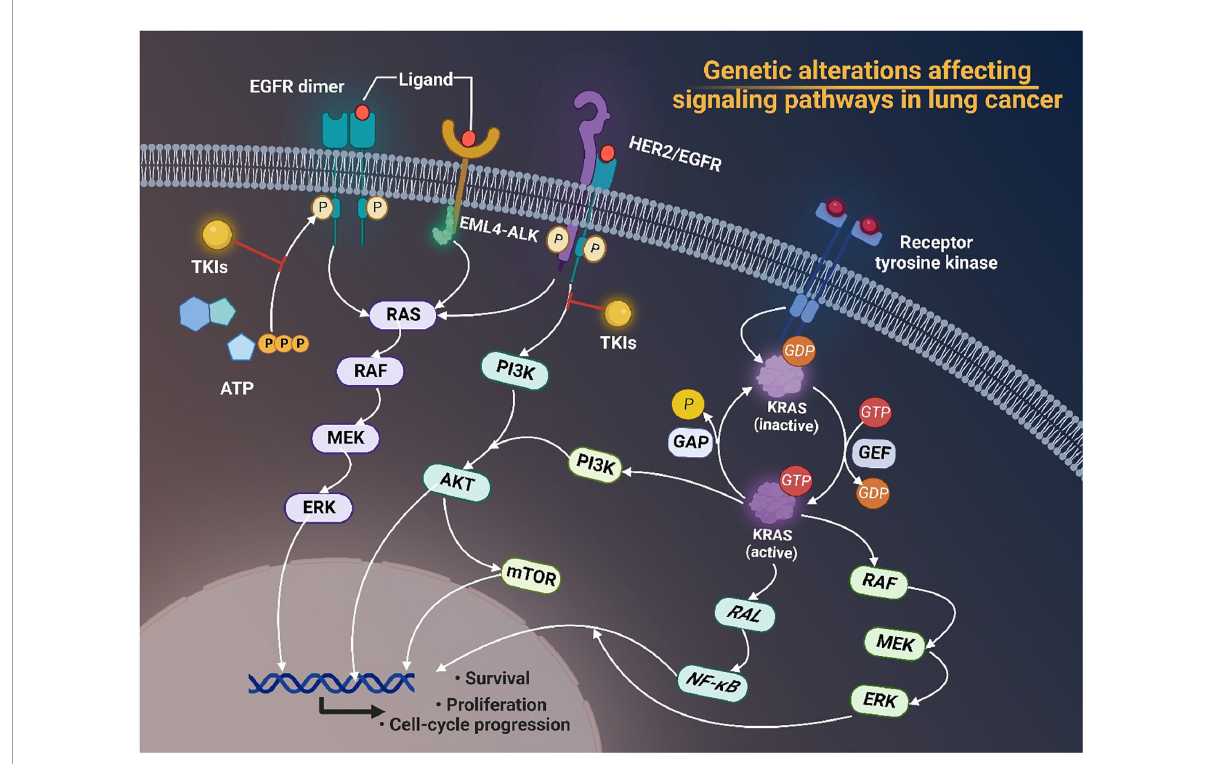
FIGURE1 Genetic alterations of EGFR, ALK, and HER2 affecting signaling pathways in lung cancer. Tyrosine kinase inhibitors (TKIs) target receptor tyrosine kinases and prevent phosphorylation of the TK domain receptor of EGFR, thus inhibiting the activation of downstream signaling pathways such as the RAS/RAF/MEK/ERK pathway and the phosphatidylinositol 3-kinase (PI3K)-AKT pathway, thereby interfering with cell proliferation, differentiation, migration and survival. Activated KRAS proteins principally activate the downstream PI3K-AKT-mTOR signaling pathway that regulates cell proliferation and the RAS-RAF-MEK-ERK signaling pathway that regulates cell growth. Tumorigenic alterations contribute to EGFR overexpression, which ultimately increases the risk of cancer development by regulating related signaling pathways. EGFR, epidermal growth factor receptor; TKI, tyrosine kinase inhibitors; EML4-ALK, echinoderm microtubule associated protein like 4-activin-like kinase; HER2, human epidermal growth factor receptor 2; ATP, adenosine triphosphate; MEK, MAP kinase-ERK kinase; ERK, extracellular regulated protein kinases; PI3K, phosphoinositide 3-kinase; mTOR, mammalian target of rapamycin; GAP, growth-associated protein; GDP, guanosine diphosphate; GTP, guanosine triphosphate; GEF, Granule, Effervescent; RAL, Ras-like; NF- κ B, nuclear factor-kappa B; RAF, rheumatoid arthritis factor; ERK, extracellular regulated protein